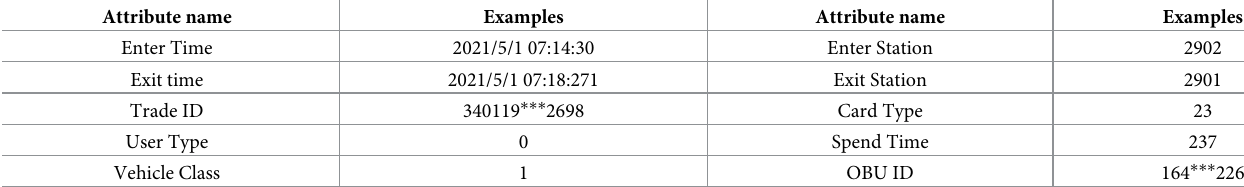
Table 2. Toll system partial transaction data attribute tablee.